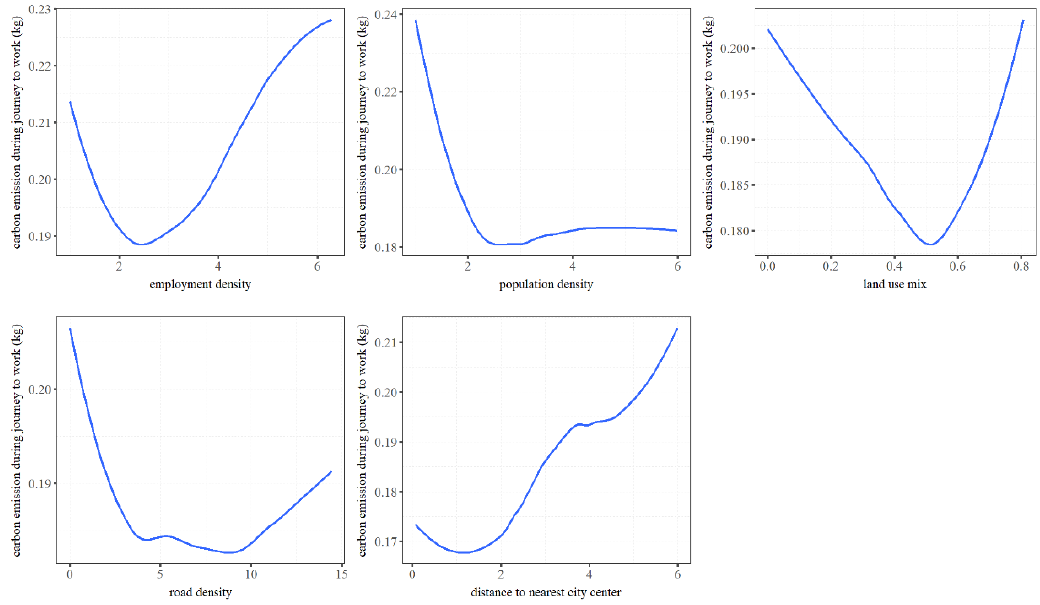
Figure A4. Nonlinear effects of other built environment features on carbon emissions in suburban areas.